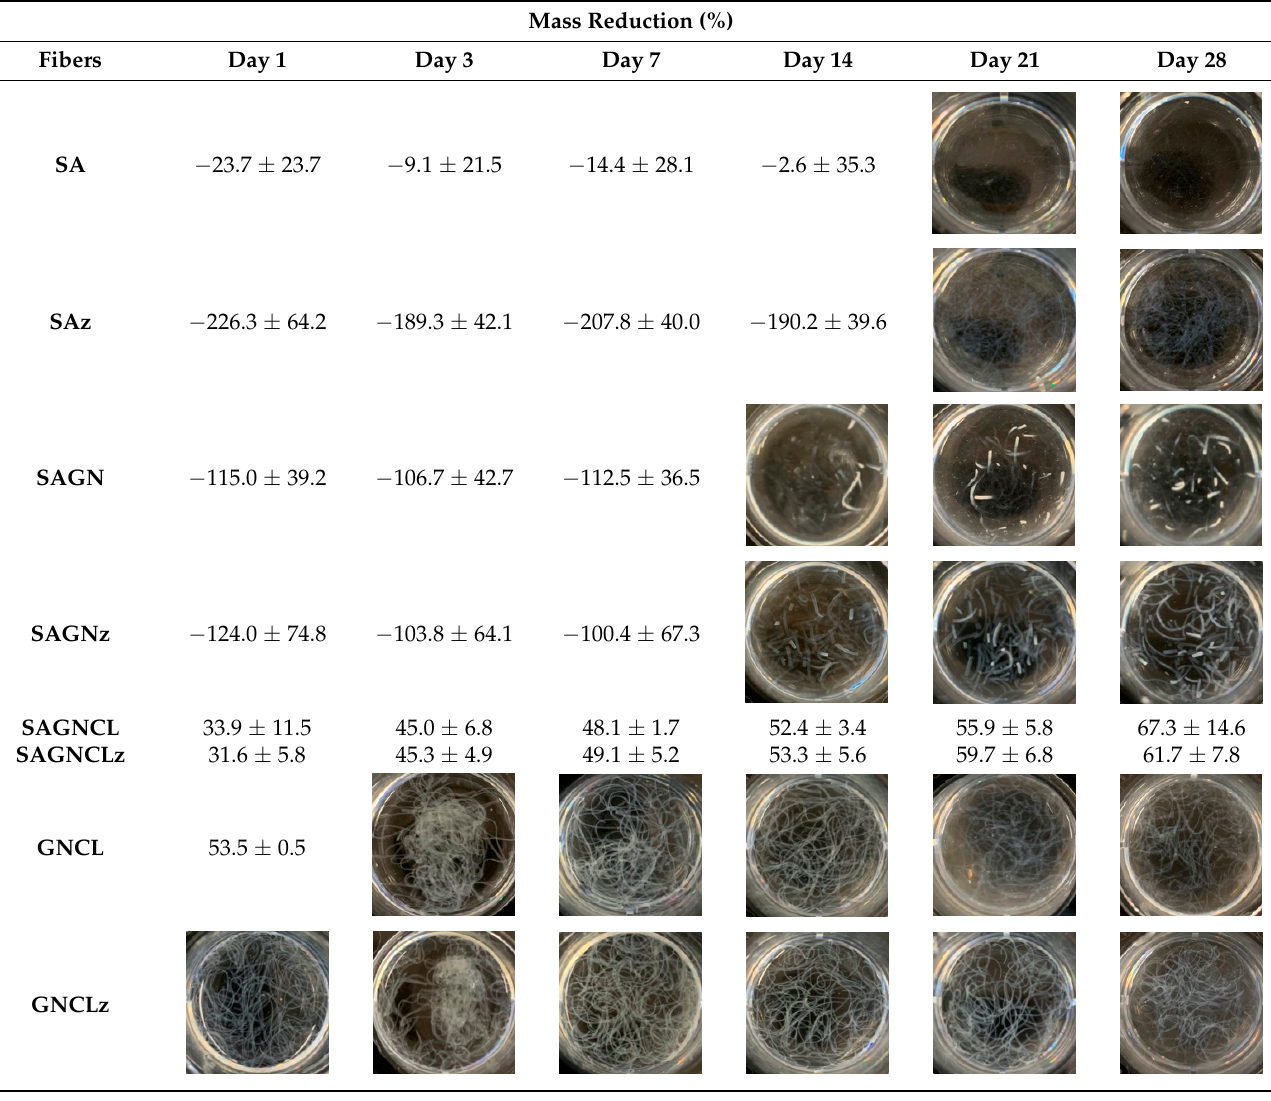
Table 2. Microfibers degradation profile over a period of 28 days in simulated body fluid (SBF) at pH 7.4. Data is presented in percentage of mass reduction ± S.D. ( n = 3).